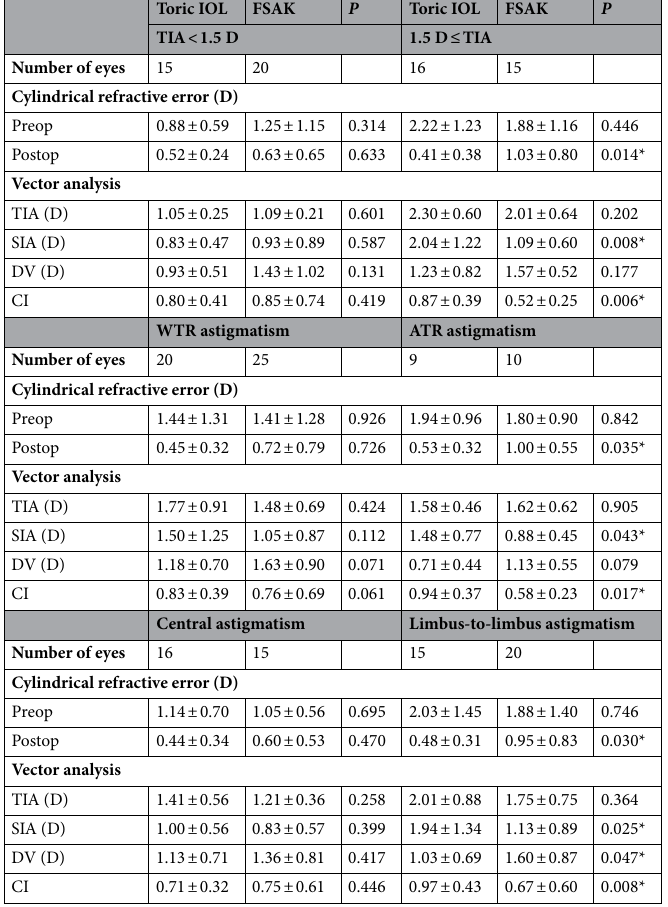
IR is a number or index representing the degree of irregularity in the corneal surface morphology. It is a meas- ure of the standard deviation between the corneal surface and the best-fit reference surface. It can often be used to predict irregular astigmatism or visual distortions 27,28 . High values of this ratio indicate a greater possibility of corneal pathology related to morphological abnormality such as keratoconus. Evaluation of corneal aberration revealed a significant increase in RMS HOAs and IR in the FSAK group compared with the conventional toric IOL group. The aberration in our study was consistent with previous reports 29–32 . In our study, the FSAK might induce visual defects such as glare and halo by increasing HOAs and corneal irregularity compared with toric IOL implantation; however, the authors did not investigate the postoperative visual challenges. A further study is needed to elucidate the effect of FSAK on the quality of subjective vision. Based on the subgroup analysis according to the direction of preoperative corneal astigmatism, the effect of FSAK was significantly lower than that of toric IOL implantation when correcting ATR astigmatism. When correcting WTR astigmatism, the primary corneal incision was located at the temporal corneal meridian and the AKs were paired with symmetric incisions centered on the vertical axis. However, when correcting ATR astig- matism, the main incision was located at the vertical meridian and the AKs were paired on the horizontal axis. In this case, regardless of the type of astigmatism, the primary corneal incision offsets the effect of astigmatism correction of AKs. It has been known for many years that a superior clear corneal incision induces substantially higher degree of astigmatism than temporal incision 33–36 . In our study, the effect of canceling astigmatism cor- rection was greater in ATR astigmatism in which the main incision is vertical compared with the horizontal incision in WTR astigmatism, which was in line with the previous studies. Traditionally, astigmatism is divided into roughly two types: central and limbus-to-limbus corneal astigmatism 37 . The limbus-to-limbus astigmatism is characterized by a typical bowtie shape extending to the limbus. No difference in astigmatism correction was found between the toric IOL and FSAK groups in central astigmatism, whereas in limbus-to-limbus astigmatism, the CI of FSAK group was significantly lower than in the toric IOL group. The viscoelastic properties of the cornea appear to play an important role in these results. The layered orientation of the human cornea has been associated with mechanical properties 38,39 . The mechanical